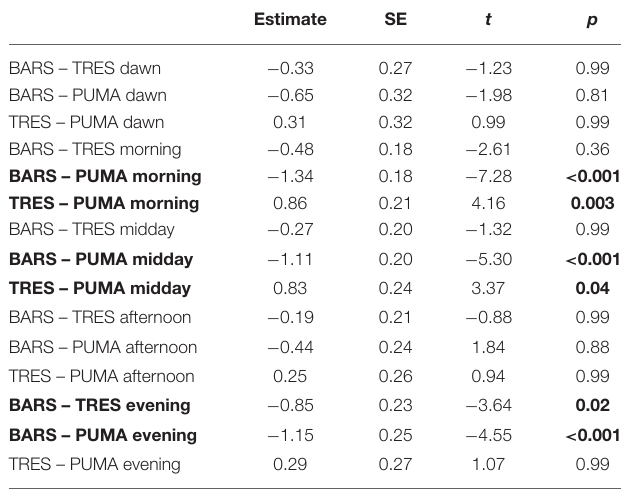
TABLE 3 | Post-hoc independent contrasts of time bins.